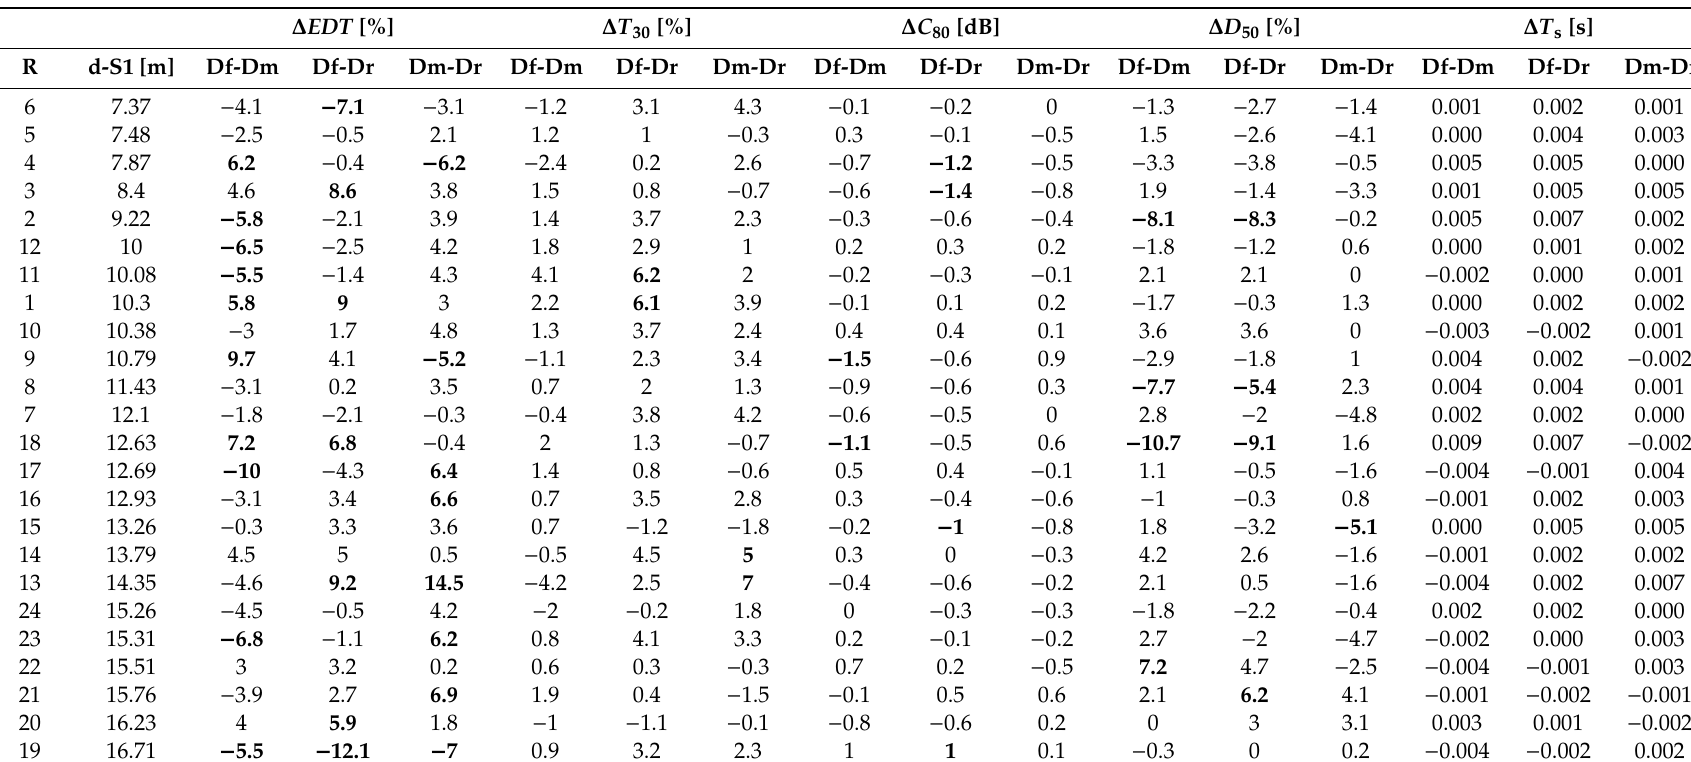
Table A3. Objective acoustic parameter di ff erences between the configurations with di ff erent di ff user locations in the absorptive (-A) condition for